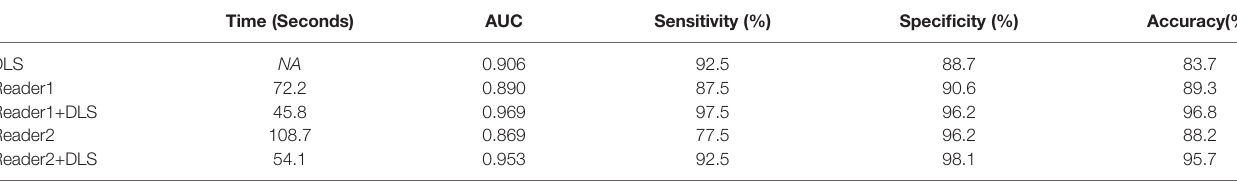
DLS, deep learning system; NA, not